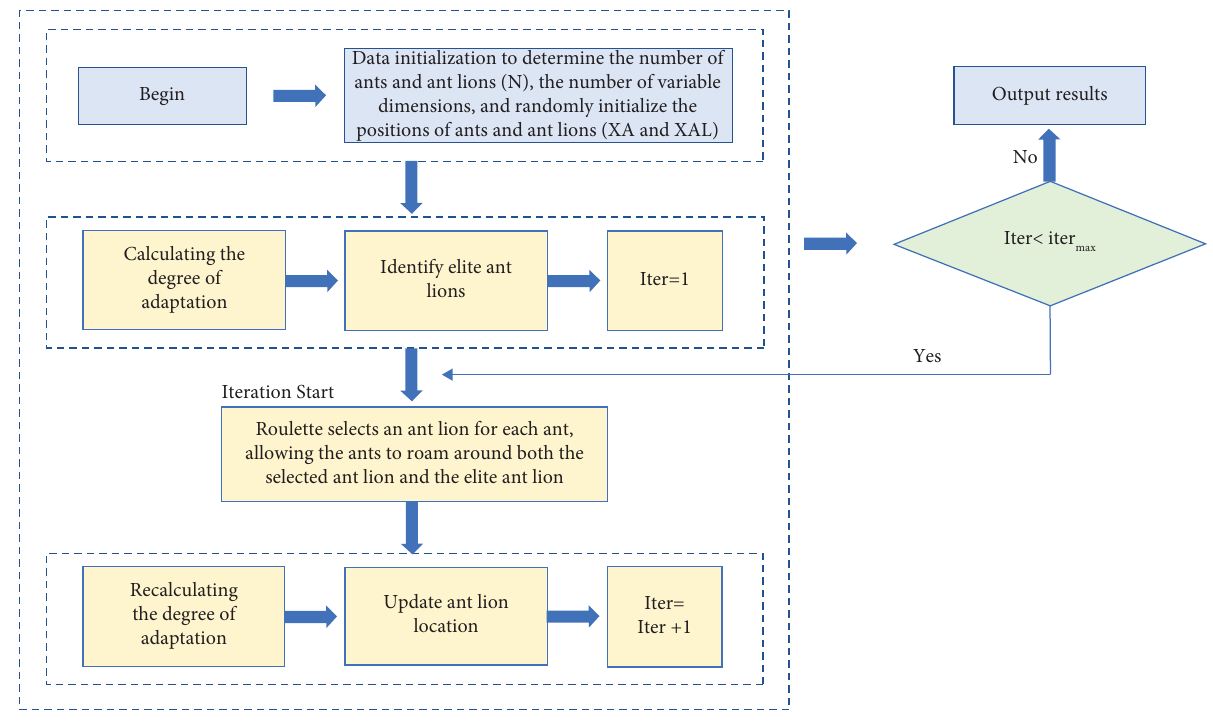
Figure 2: Flow of the ant lion optimization algorithm.